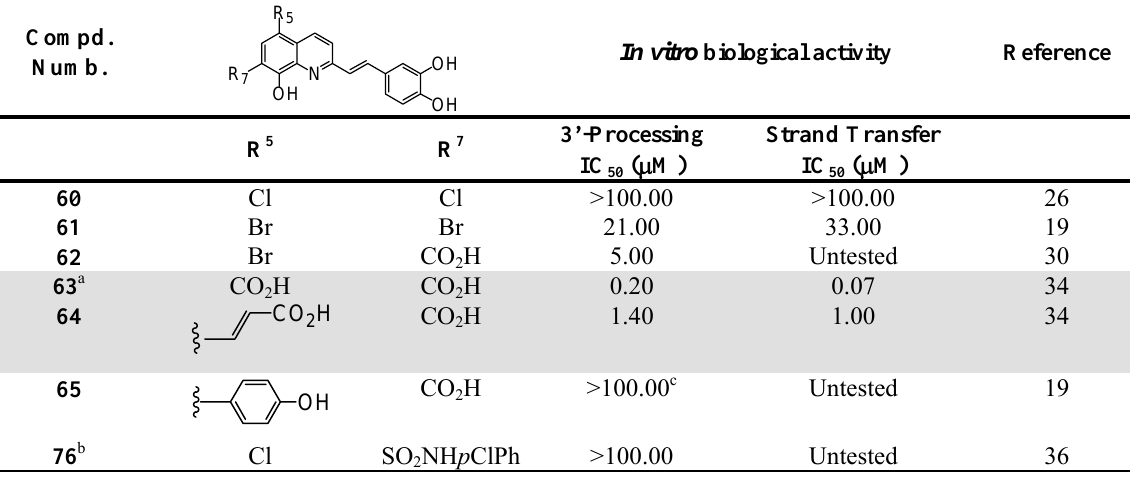
Table 5. HIV-1 IN inhibitory potency of 5,7-disubstituted -8-hydroxystyrylquinoline derivatives. Compd.